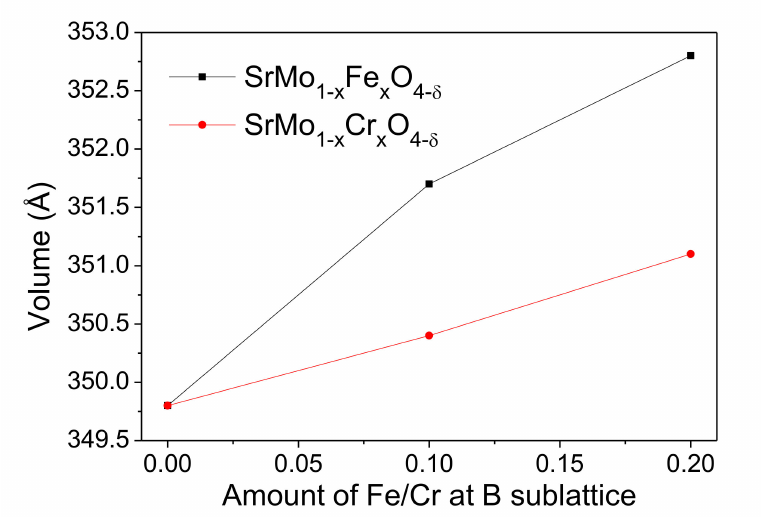
Figure 2. Variation of the unit-cell volume as a function of the M-doping content, from XRD